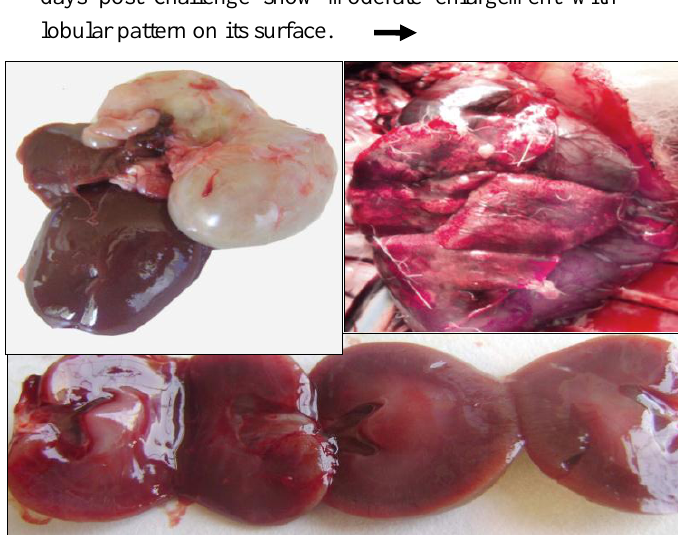
Fig:4 Gross rabbit lung, liver and kidney of 3rd (positive control) group at 24-48hr. post challenge show severe congestion in these organs with multiple consolidating foci mainly in lung parenchyma.